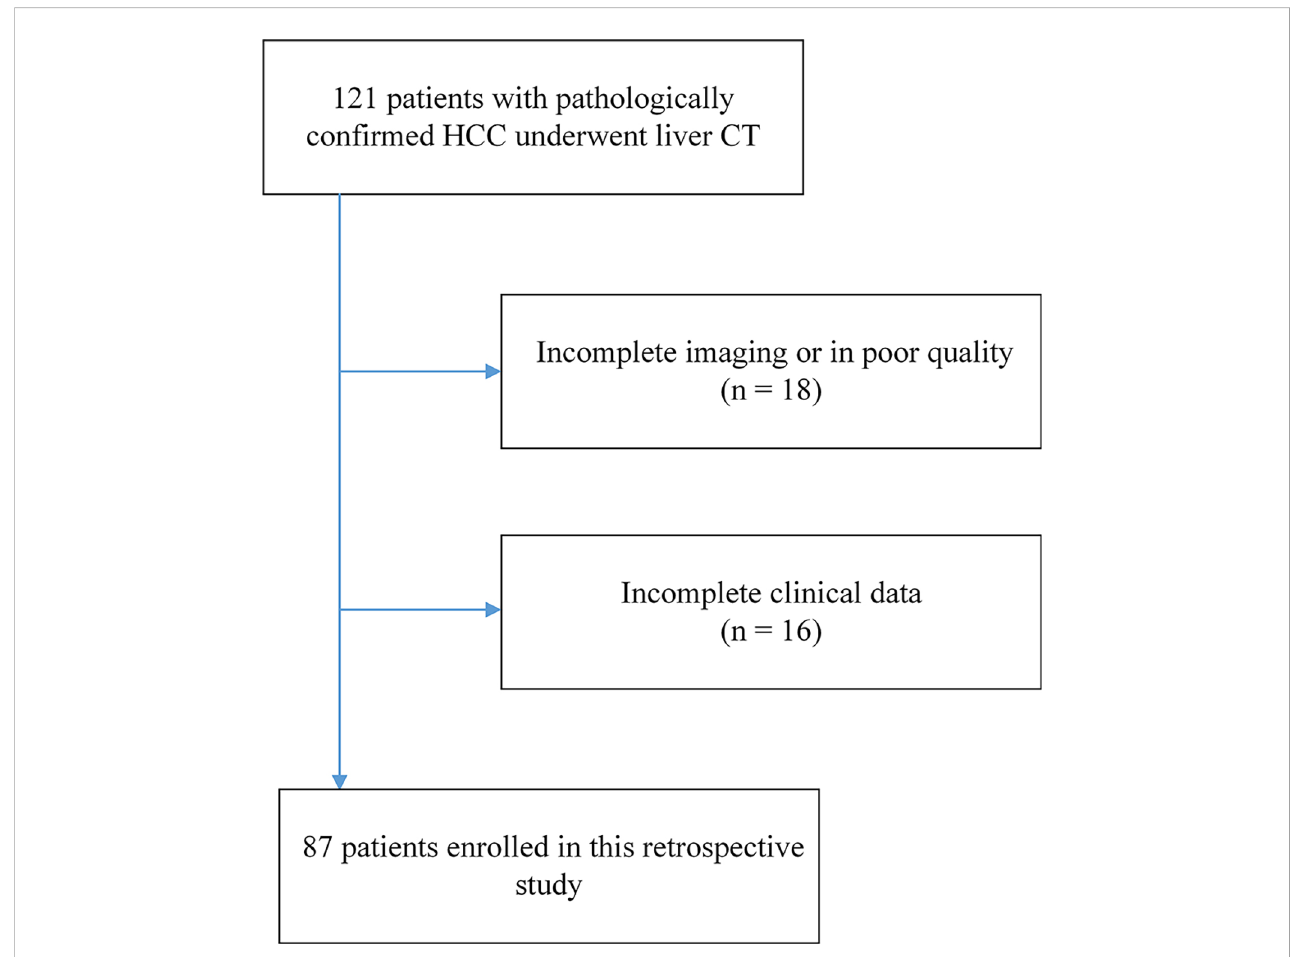
FIGURE 2 The fl owchart of patient enrollment. A total of 87 patients with HCC from 121 were fi nally enrolled in this